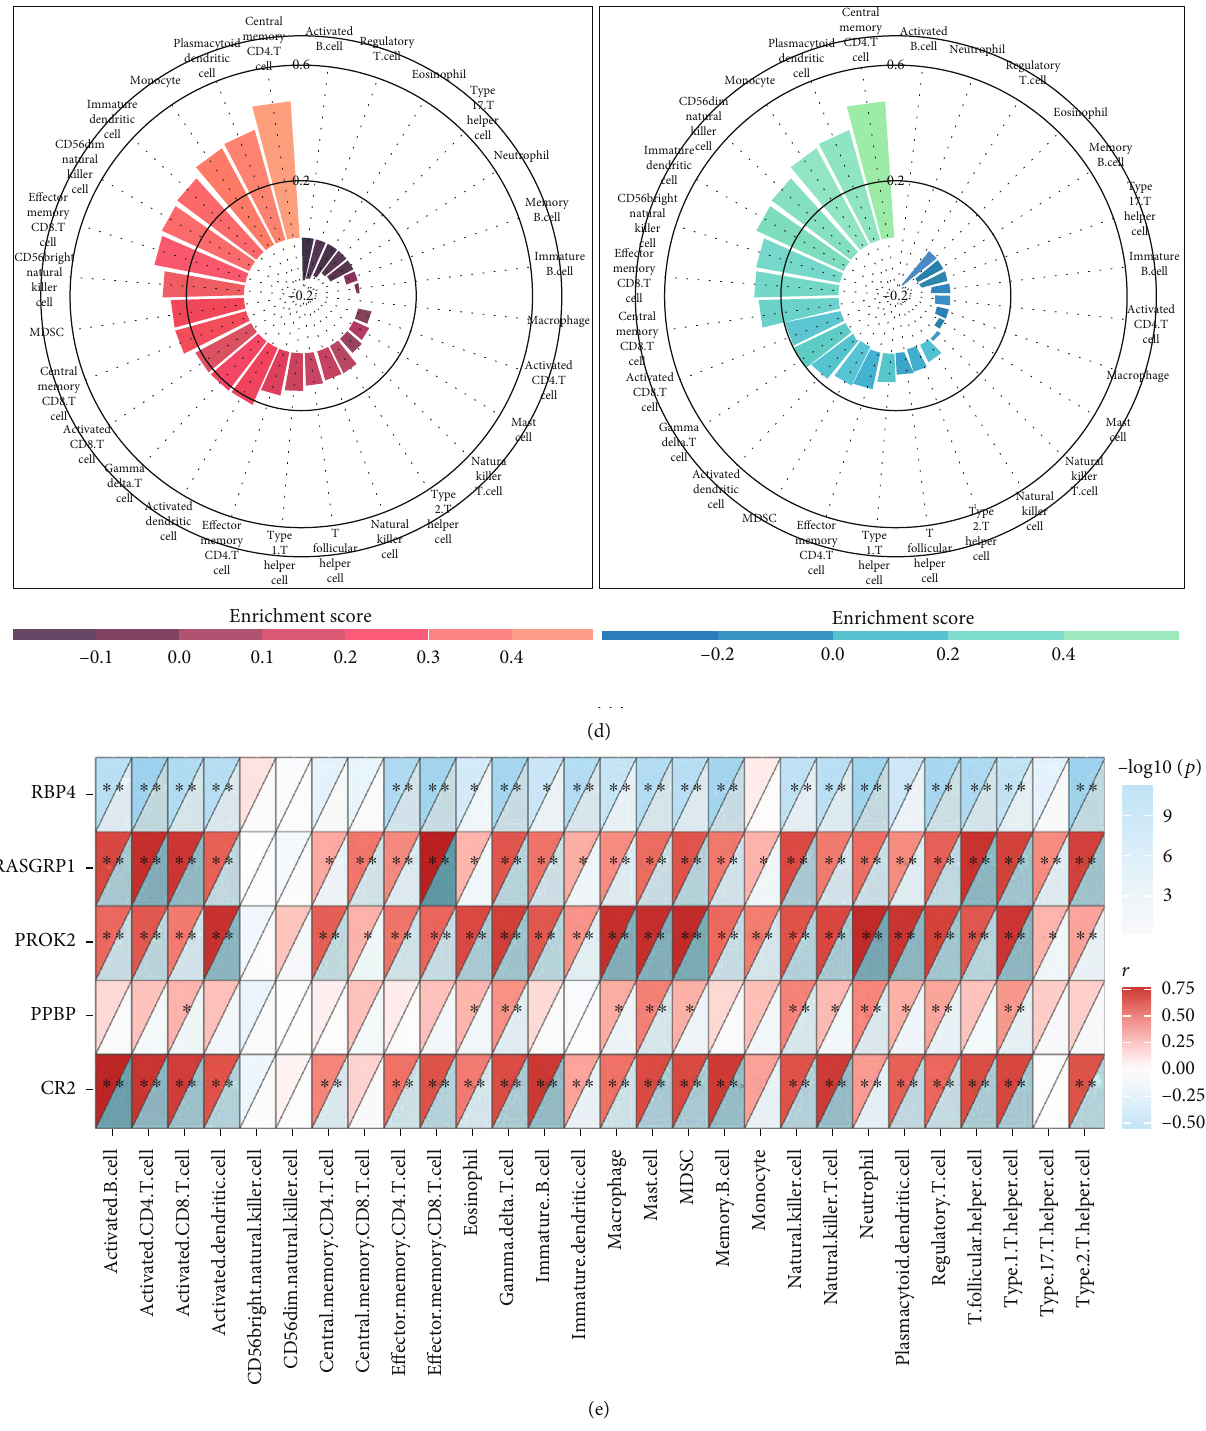
Figure 5: Immune status of IC. (a) The violin plot shows that both adaptive and innate in fi ltrated immune cells performed abundant enrichment in the IC cohort compared with the normal control cohort. (b) Correlation analysis revealed the remarkable interactions between 28 in fi ltrated immune cells. (c) The logistic regression model also showed that most of the immune cells were positively correlated with the diagnosis of IC. (d) The radar plot visualized the scores of in fi ltrated immune cells. (e) Correlation analysis of in fi ltrated immune cells and IC characteristic genes. ∗ represents p < 0 : 05 , ∗∗ represents p < 0 : 01 , and ∗∗∗ represents p < 0 : 001